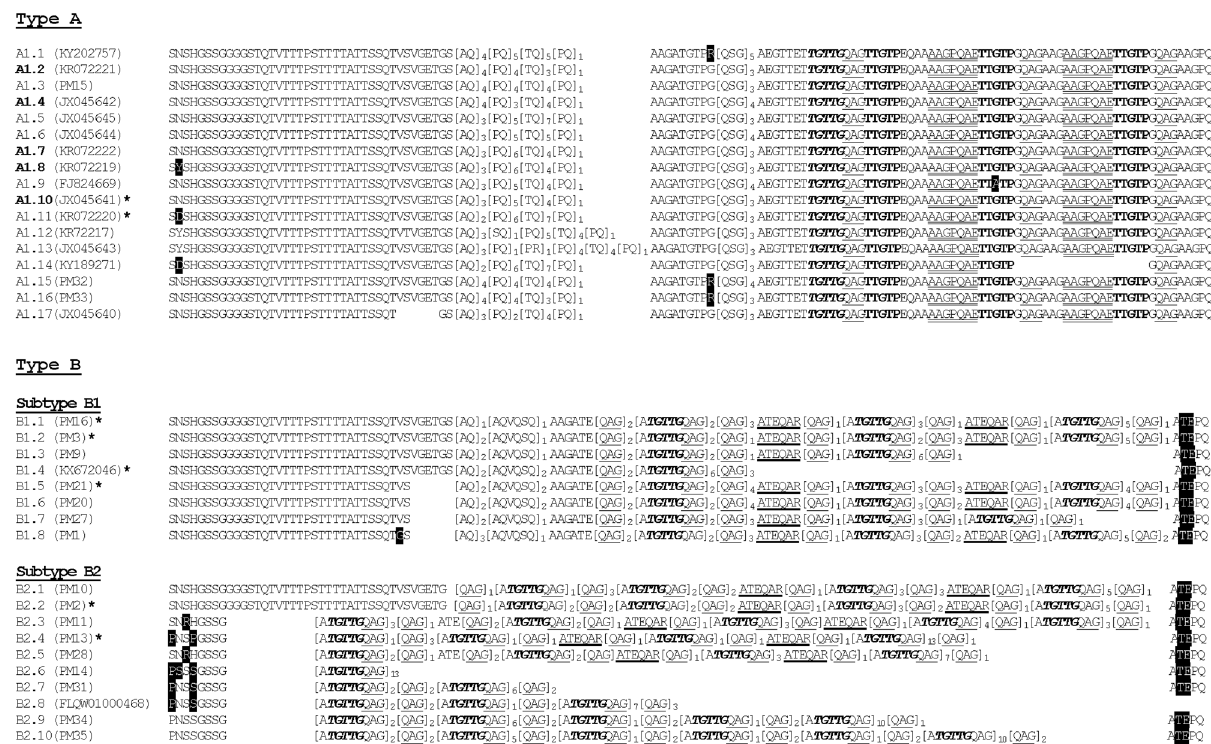
Figure 3. Variation in block VI of PmMSP1 spanning amino acid residues 683 and 827 (positions after GenBank accession no. FJ824669). Repeats are shown in brackets, bolds, italics or underlined residues. Numbers of repeat units are indicated by subscripts. Mutations in nonrepeat regions are highlighted. Representative isolates are shown in parentheses after the alleles. Alleles in bolds are found in P. brasiliamum. Allele A1.10 belongs to both P. malariae (KR072216) and P. brasilianum (JX045641). Asterisks denote alleles with two or more isolates: KR072218 and KR072215 in allele A1.11; PM17-PM19 in allele B1.1; PM3-PM7 in allele B1.2;